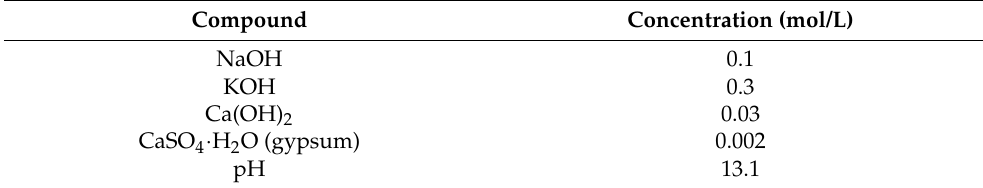
Table 3. Chemical compositions and pH of the simulated concrete pore